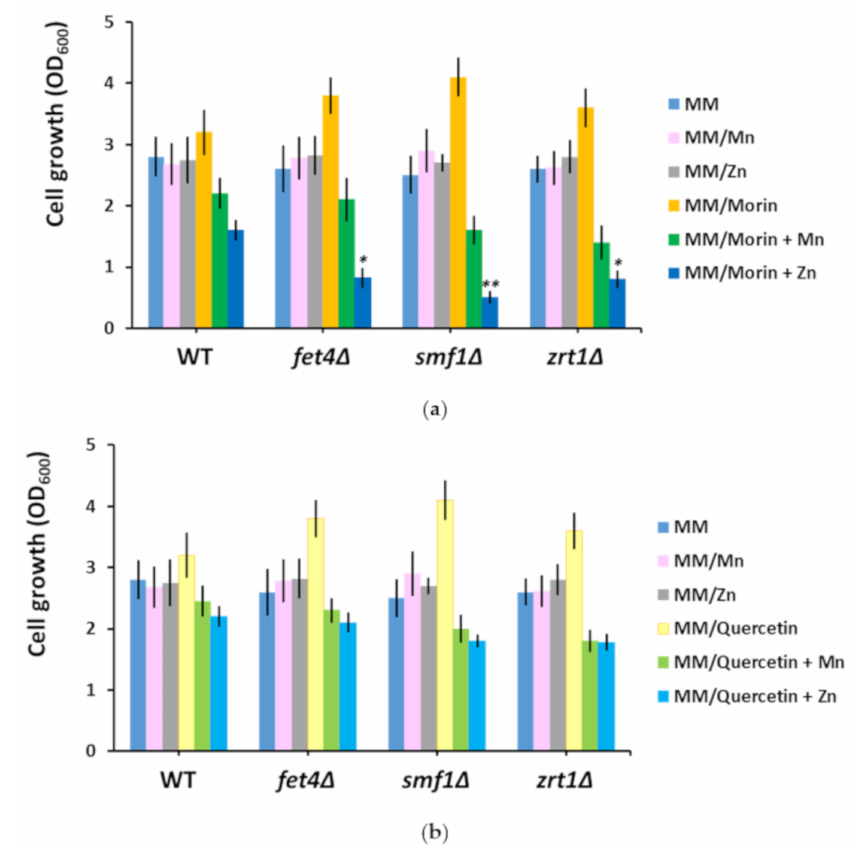
Figure 3. E ff ect of manganese and zinc supplementation on the growth of cells exposed to morin ( a ) and quercetin ( b ). Exponentially growing wild type (WT), fet4 ∆ , smf1 ∆ , and zrt1 ∆ cells were inoculated (OD 600 = 0.05) in liquid minimal defined medium (MM) supplemented with the indicated compounds. Cell growth was determined spectrophotometrically (OD 600 ) after 16 h of incubation (200 rpm, 30 ◦ C). Values are mean ± SEM of triplicate determination done on three biological repeats. The concentrations of morin, quercetin, and supplementary Mn and Zn were 100 µ M each. Two-way ANOVA; * p < 0.05, ** p <